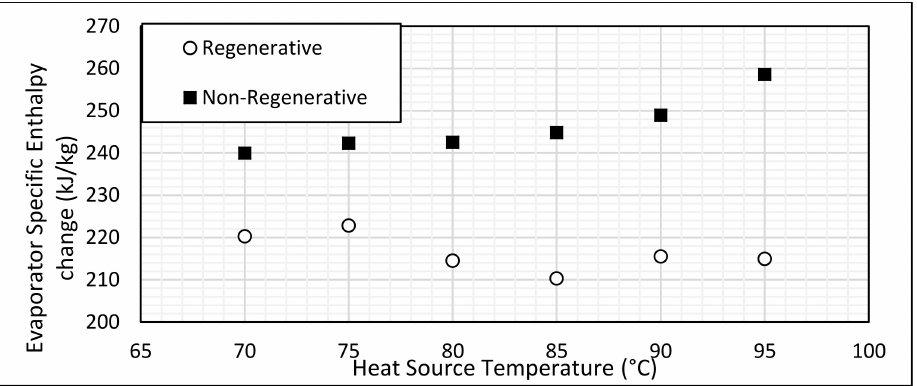
Figure 10. Variation in evaporator-specific enthalpy change with changing heat source temperature for regenerative and non-regenerative cycles and a pump speed of 40 Hz.